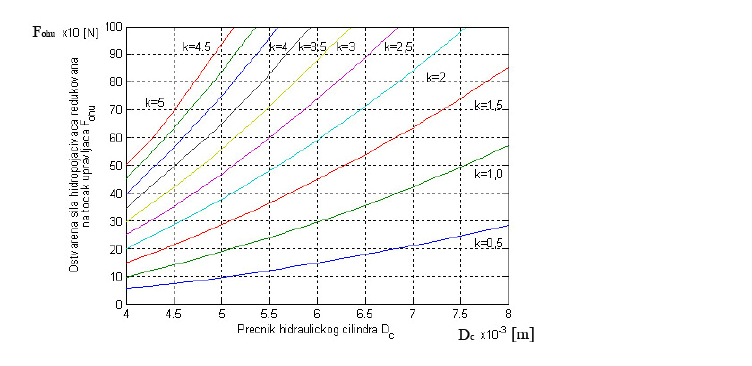
F of the reduced force on the steering wheel Figure 2 – Curves of the maximum force ohc in relation to the hydrocylinder diameter for different coefficients k (Lisov, 1961) Reaktivni i centriraju ć i elementi servoure đ